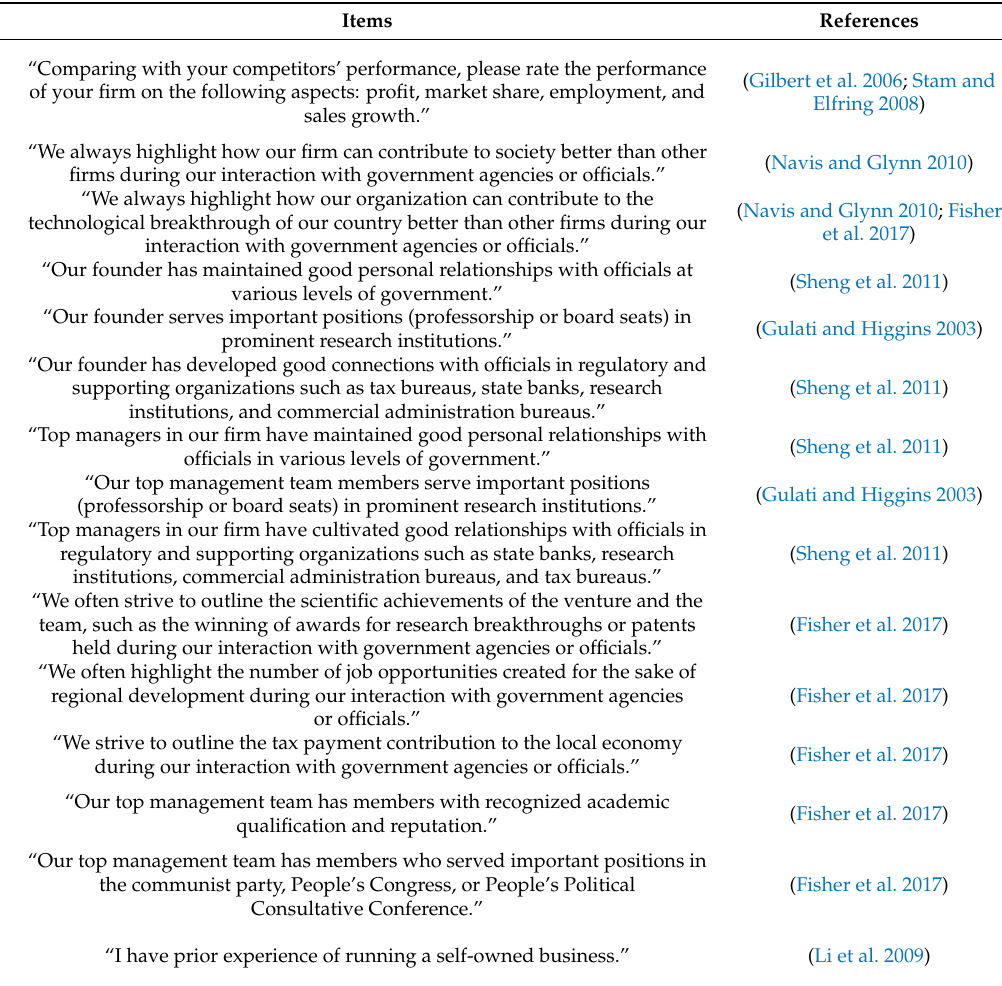
Table 1. Descriptions of variables, survey items, and